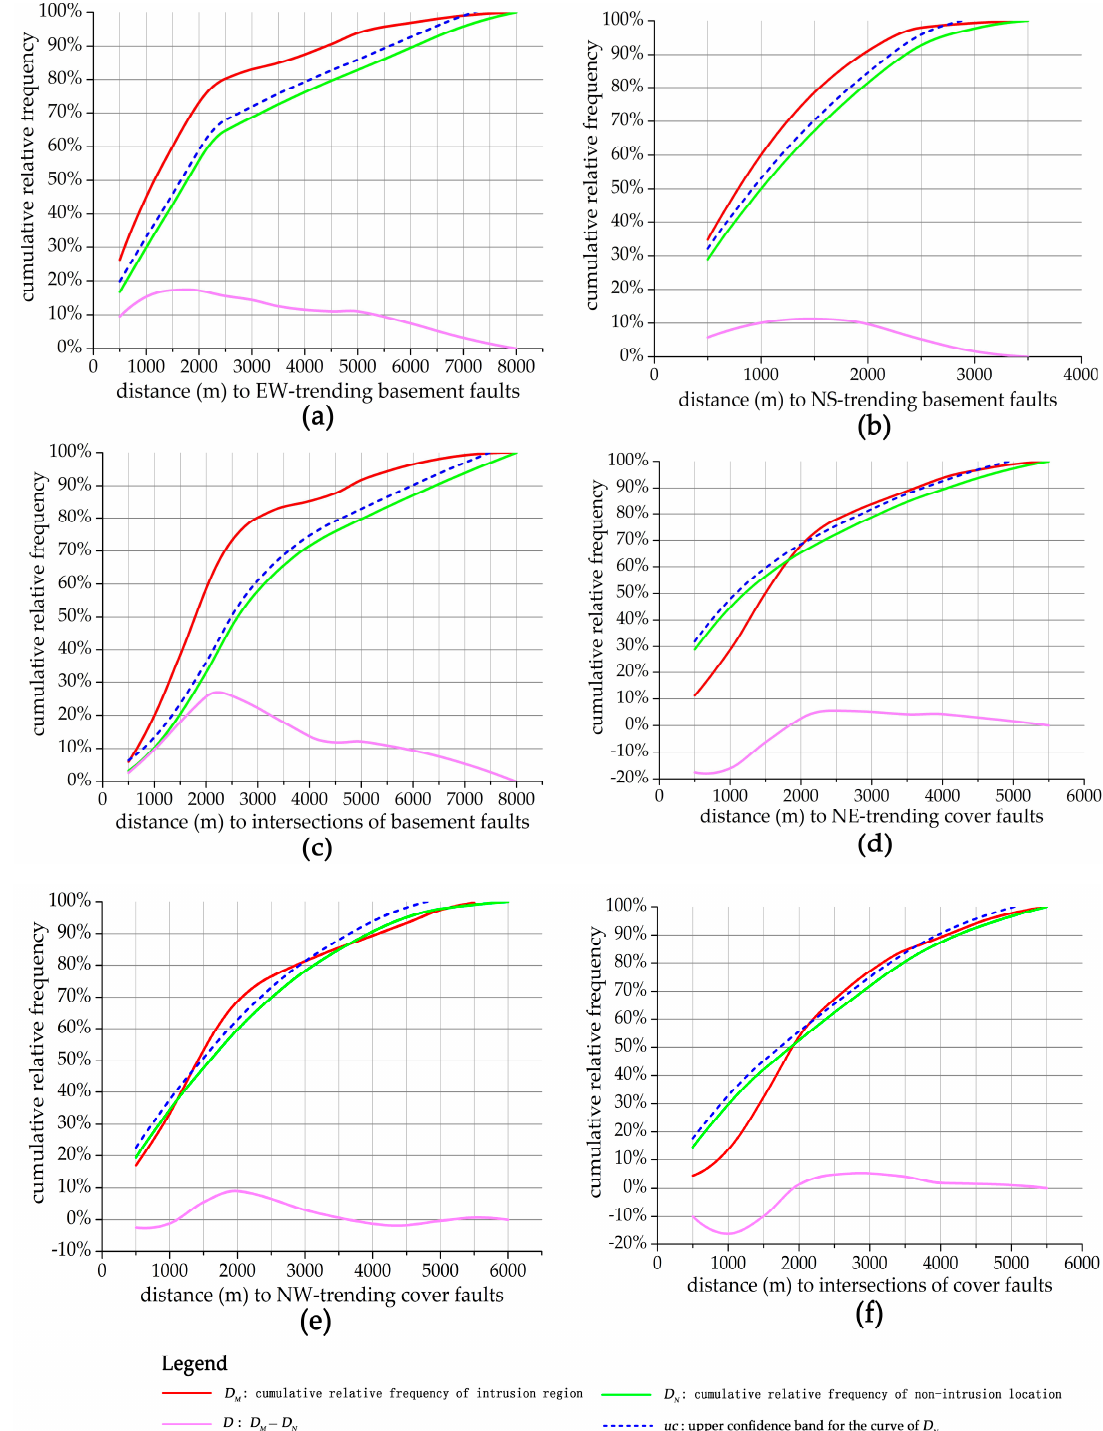
Figure 14. ( a ) Buffer analysis and ( b ) graph of cumulative relative frequency concerning distance to boundaries of intrusions.